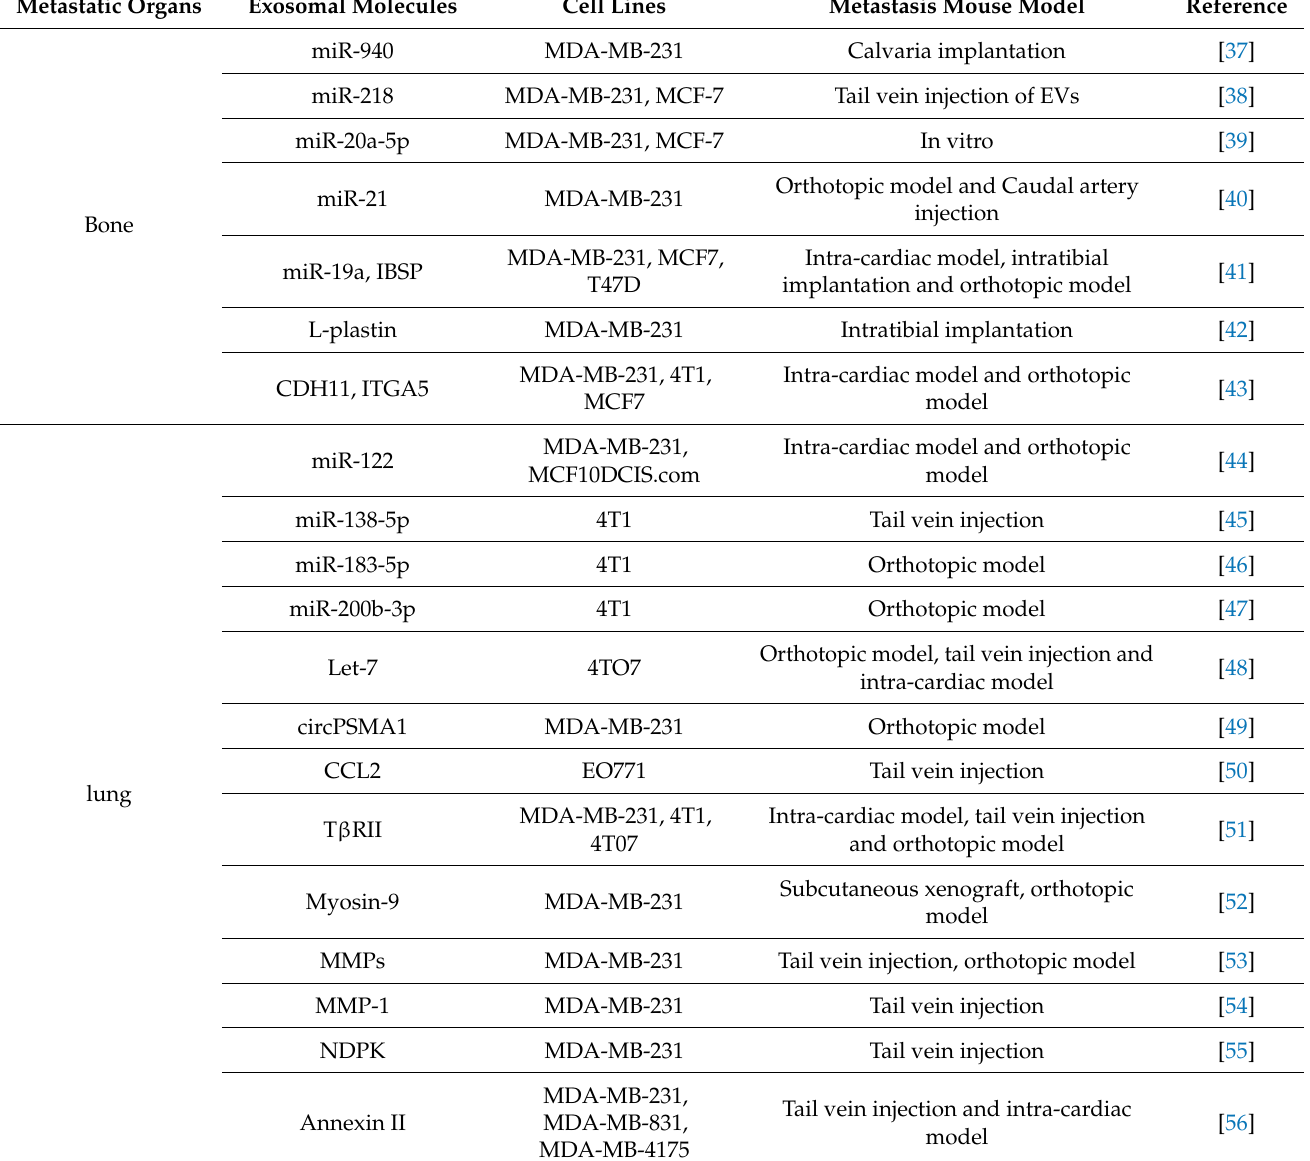
Table 1. Breast cancer models used to study the mechanism of exosomes promoting